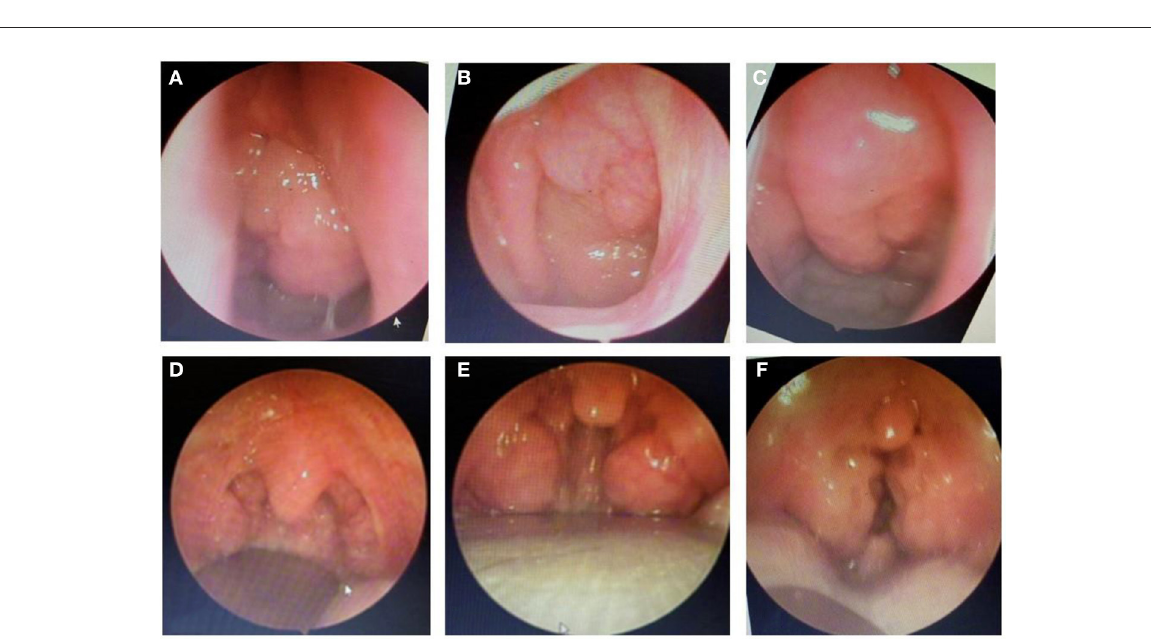
the total number of apnea and hypopnea divided by the number of sleeping hours. In children, the cut-off of AHI from 1–5, 5–10 and > 10 has been used to refer to mild, moderate, and severe OSA respectively (25). This cut-off is much lower than those in adults (from 5–15, 15–30 and > 30). Previous